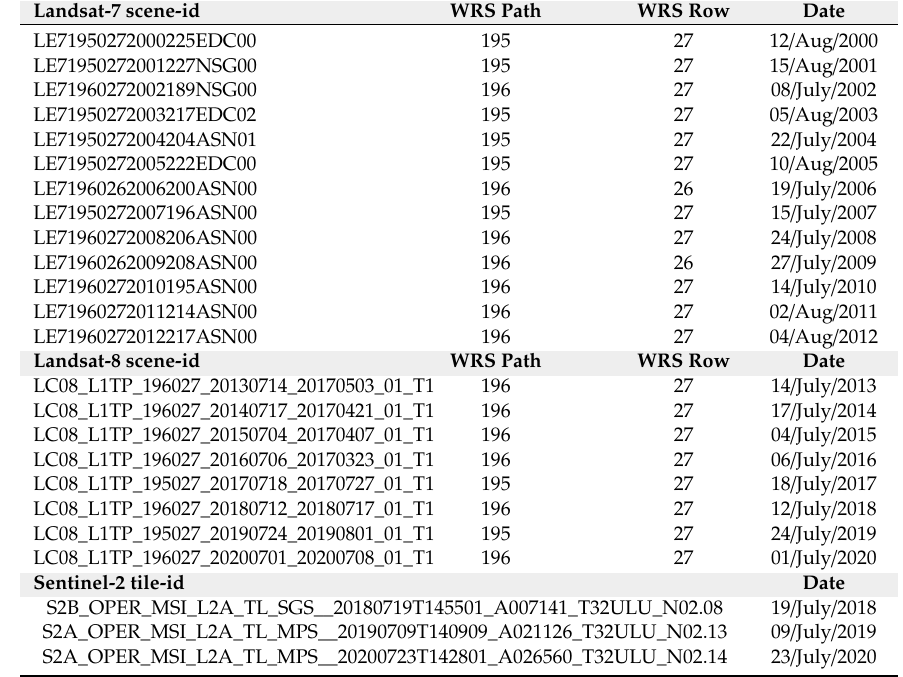
Table 1. Landsat-7, Landsat-8, and Sentinel-2 images, which were used to calculate the NDVI